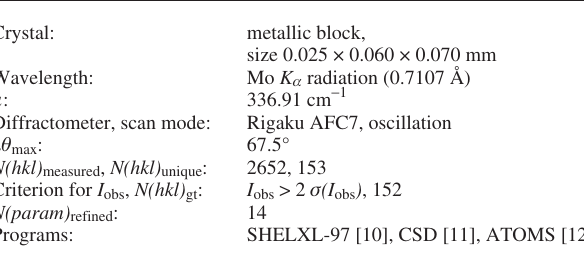
Table 3. Data collection and handling.